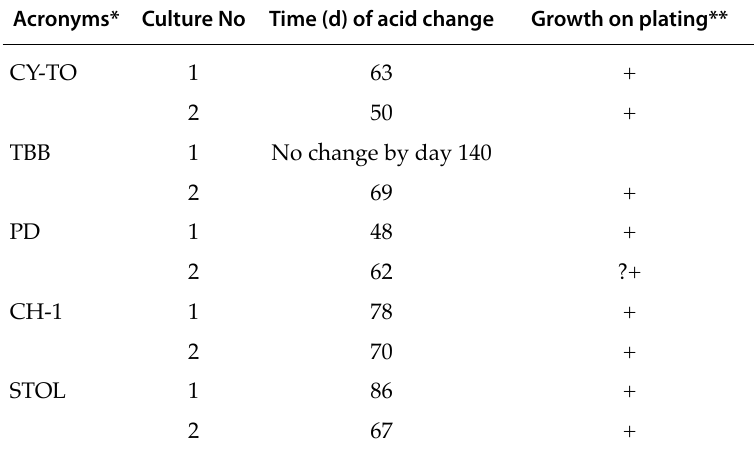
Table 2. Results of phytoplasma growth from infected micropropagated periwinkle shoots transferred in sterile water 10 d before isolation in liquid